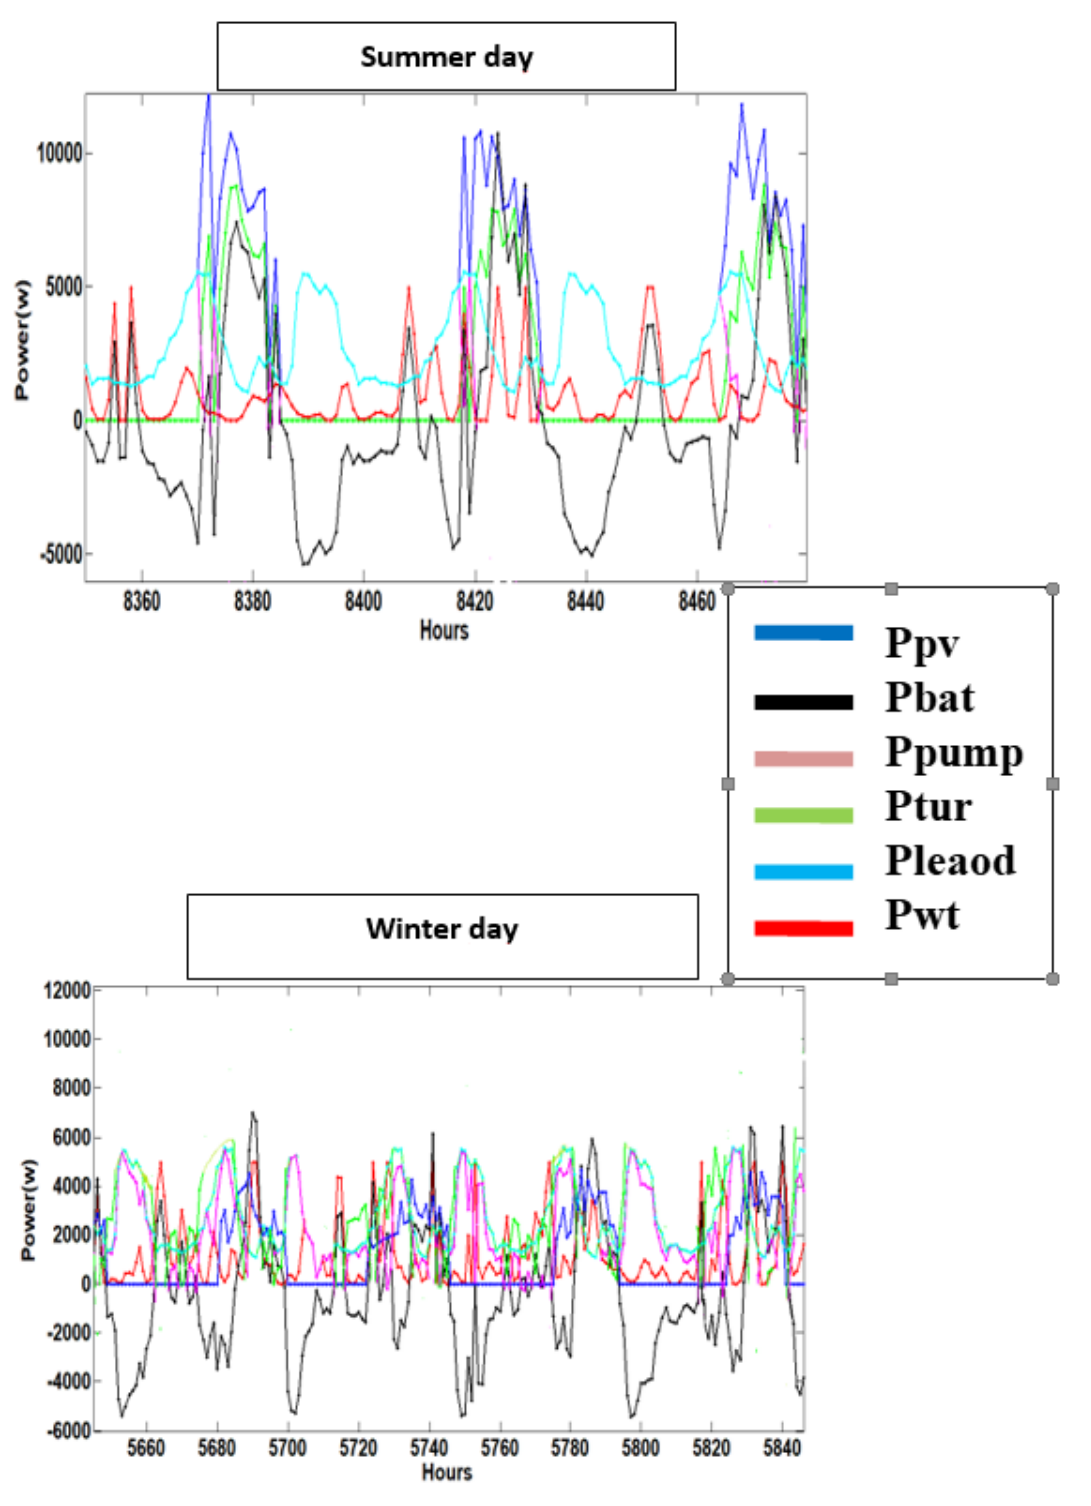
Figure 19. Power evolution for two typical days: one in summer and the other in winter.